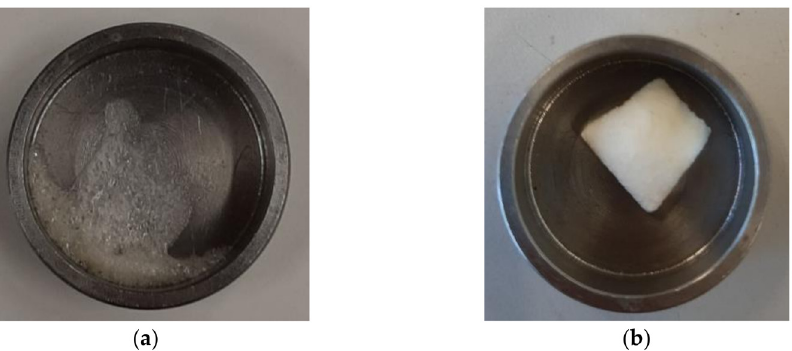
Figure 5. Macroscopic structure of electrospun PCL films after contact with scCO 2 : ( a ) not optimized and ( b )